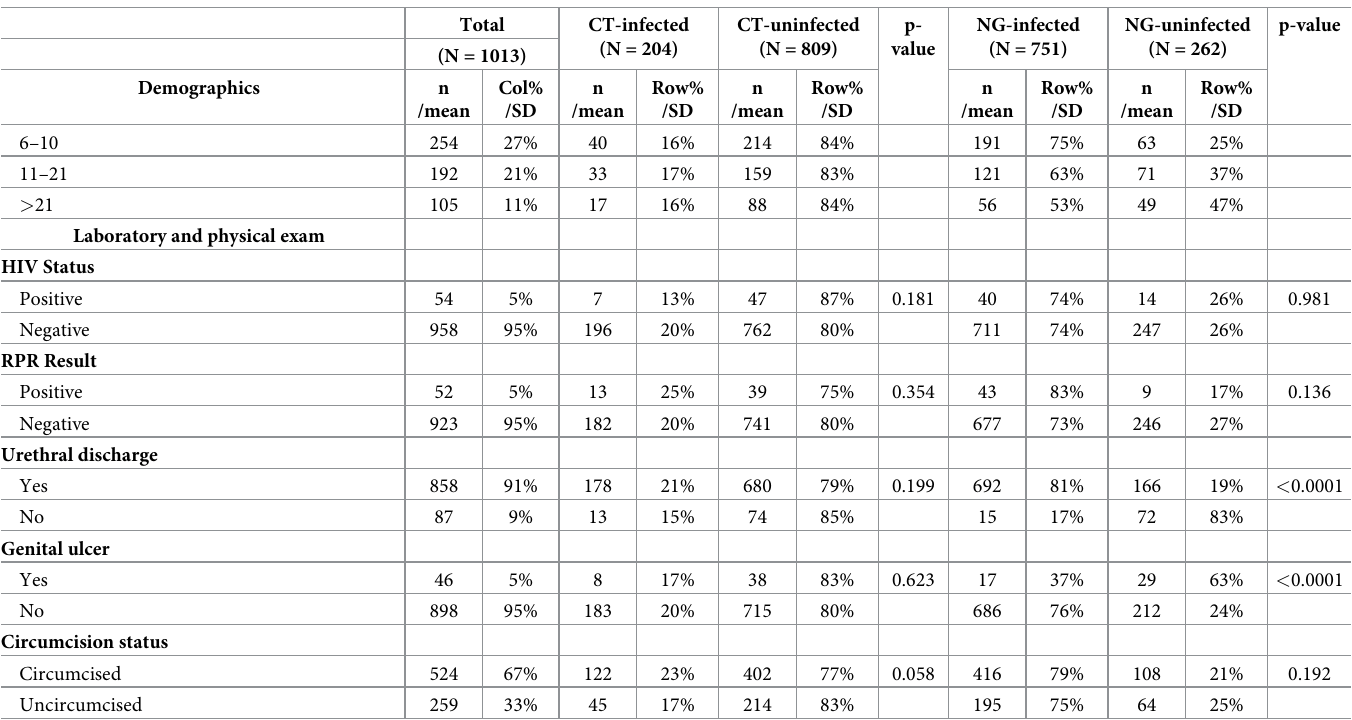
Multivariate analyses (Table 5) showed younger age, lower education and lack of full-time employment, sometimes using condoms vs . never, using hormonal contraception vs . other or no contraception, not having a genital ulcer or itching, having symptoms for < = 10 days, HIV + status, endocervical discharge noted on speculum exam, BV, and negative VCA as indepen- dent factors associated with NG. Factors associated with of BV, TV and VCA in women (not tabled) Only reporting > 1 partner remained independently associated with BV in multivariate analy- ses (POR 2.21, p = 0.003). Factors associated with TV in multivariate analyses were being sin- gle and RPR+ (aPOR 2.05, p = 0.009 and aPOR 2.37, p = 0.023, respectively). Factors associated with VCA were having < = 1 partner in the last month (aPOR 4.26, p = 0.005), being pregnant (aPOR 3.05, p = 0.002), always using condoms or not having sex in the last three months vs . never using condoms (aPOR 2.42, p = 0.023), genital itching (aPOR 1.69, p = 0.034), genital discharge (aPOR 2.56, p = 0.011), and being HIV and RPR negative (aPOR 2.93, p = 0.025 and aPOR 4.94, p = 0.031, respectively). Genital ulcers in men and women (not tabled) Reported and/or observed genital ulcers were more common among HIV+ (20%) compared with HIV- (5%) men (p < 0.001). Genital ulcers were noted during physical examination